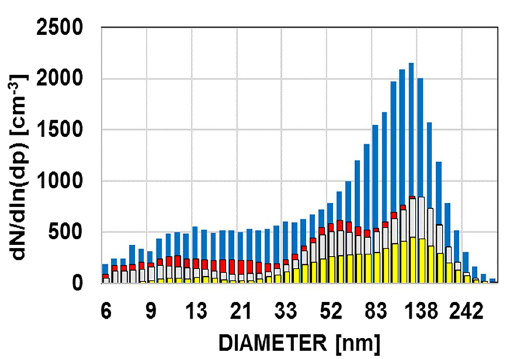
Figure 3. Size distributions measured under ‘remote’ coastal or marine conditions, averages of ~ 20 size distributions. Blue: 2–3 km above MSL over Corsica, aged particles ~ 4 to 5000 cm −3 . Over a more than two week campaign, more than 80% of all particles were classified as cloud condensation nuclei (CCN). Grey: over the forested escarpment, continental coastline north of Townsville QLD, Australia, August 2012 (~ 1600 cm −3 ) all ~ 300 to 500 m above AGL. Red: 600 m ASL over the Great Barrier Reef, Australia, August 2012, north of Townsville (~ 2000 cm −3 ) ship pollution signature at 50–60 nm. Yellow: over the flat terrain at Cape Flattery, Queensland, Australia, (~ 1200 cm −3 ), see also 21